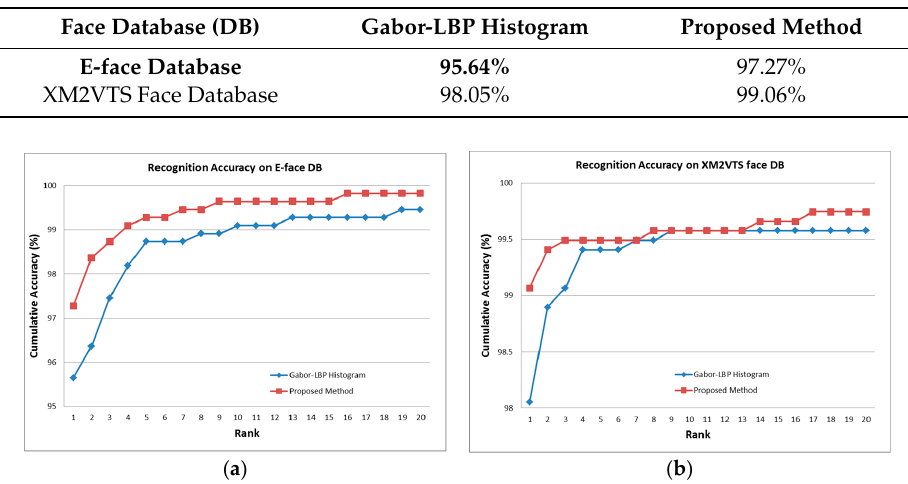
Figure 12. Cumulative accuracies of face recognition on the E-face database ( a ) and XM2VTS face database ( b ).